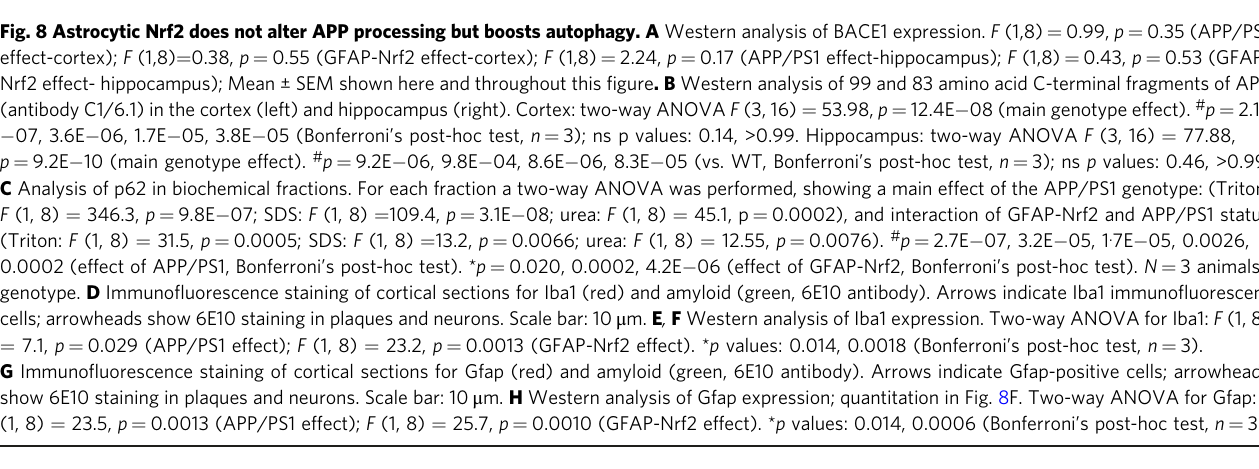
Fig. 8 Astrocytic Nrf2 does not alter APP processing but boosts autophagy. A Western analysis of BACE1 expression. F (1,8) = 0.99, p = 0.35 (APP/PS1 effect-cortex); F (1,8) = 0.38, p = 0.55 (GFAP-Nrf2 effect-cortex); F (1,8) = 2.24, p = 0.17 (APP/PS1 effect-hippocampus); F (1,8) = 0.43, p = 0.53 (GFAP- Nrf2 effect- hippocampus); Mean ± SEM shown here and throughout this fi gure . B Western analysis of 99 and 83 amino acid C-terminal fragments of APP (antibody C1/6.1) in the cortex (left) and hippocampus (right). Cortex: two-way ANOVA F (3, 16) = 53.98, p = 12.4E − 08 (main genotype effect). # p = 2.1E −